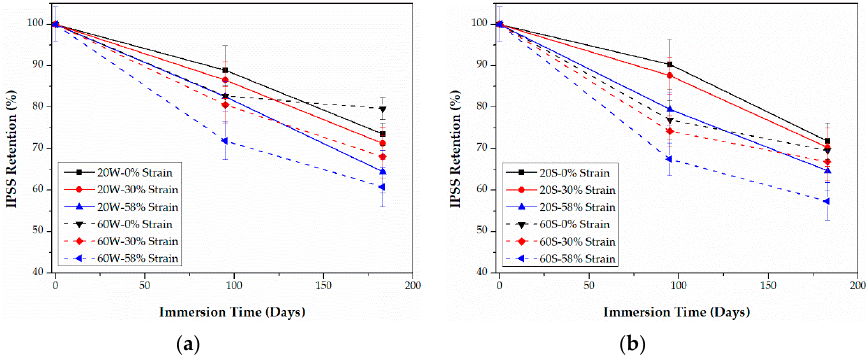
Figure 8. Retention of IPSS of PU-based CFRPs immersed in distilled water ( a ) and seawater ( b ) for 6 months, respectively.